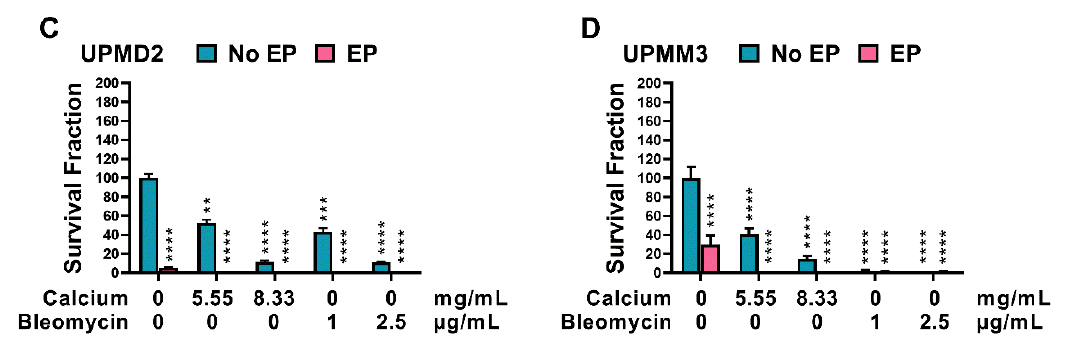
Figure 7. Survival fraction of UM and UPM spheroids following CaEP and ECT. ( A ) UM92.1, ( B ) Mel270, ( C ) UPMD2, and ( D ) UPMM3 spheroids were treated with 5.55 or 8.33 mg/mL of calcium chloride or with 1 μg/mL or 2.5 μg/mL of bleomycin in combination with EP (1000 V/cm pulse strength, 100 µs pulse duration and 5 Hz repetition frequency; EP group). Untreated cells, calcium chloride alone, bleomycin alone (no EP group), or EP alone constitute the control groups. After EP, spheroids were incubated for one week. After this incubation phase, the spheroids were dissociated, the cells were pooled and plated on a 6-well plate, and finally stained with 4% crystal violet solution. Only colonies consisting of at least 50 cells were counted. The statistical analyses were performed using a two-way ANOVA and Tukey’s multiple comparisons test. The data are presented as mean values ± SD; significance levels are indicated with * p < 0.05, ** p < 0.01, *** p < 0.001, **** p < 0.0001.